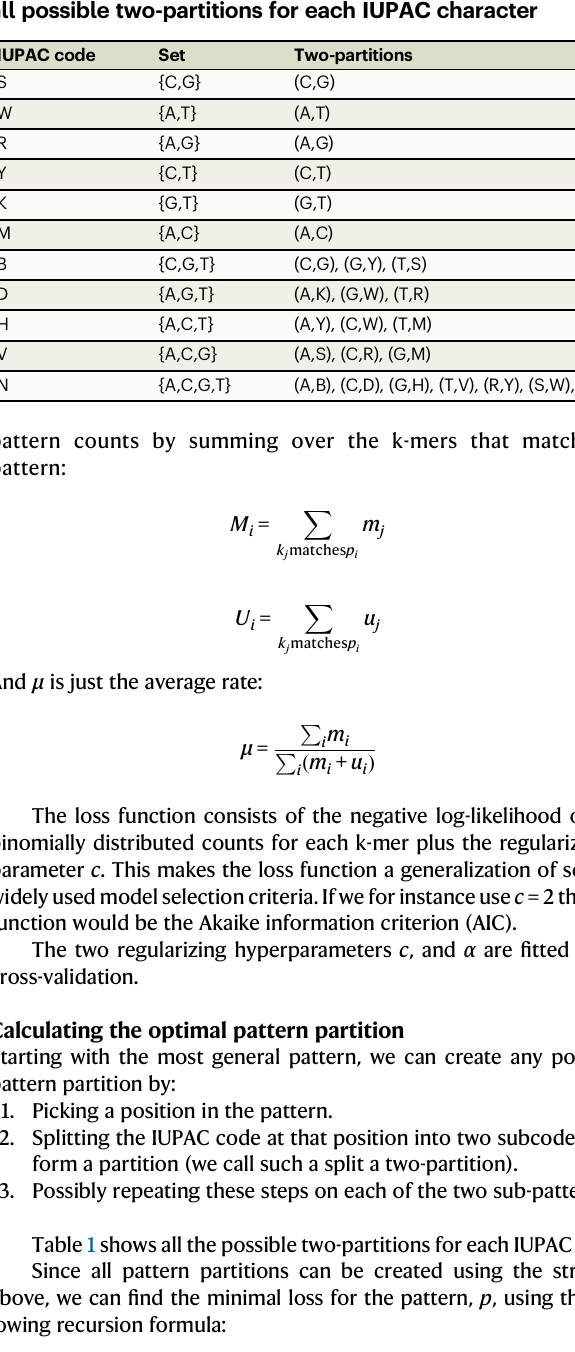
Table 1 | The de fi nition of all IUPAC characters and the list of all possible two-partitions for each IUPAC